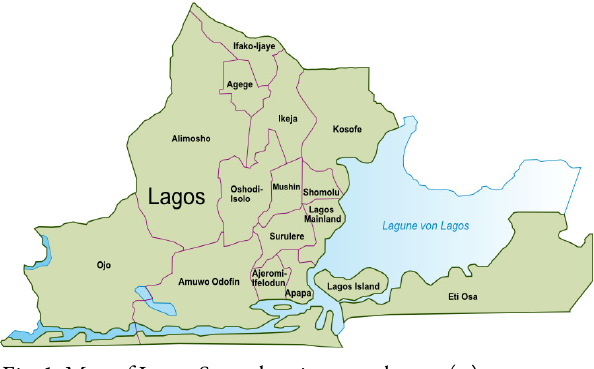
Fig. 1. Map of Lagos State showing sample area ( )